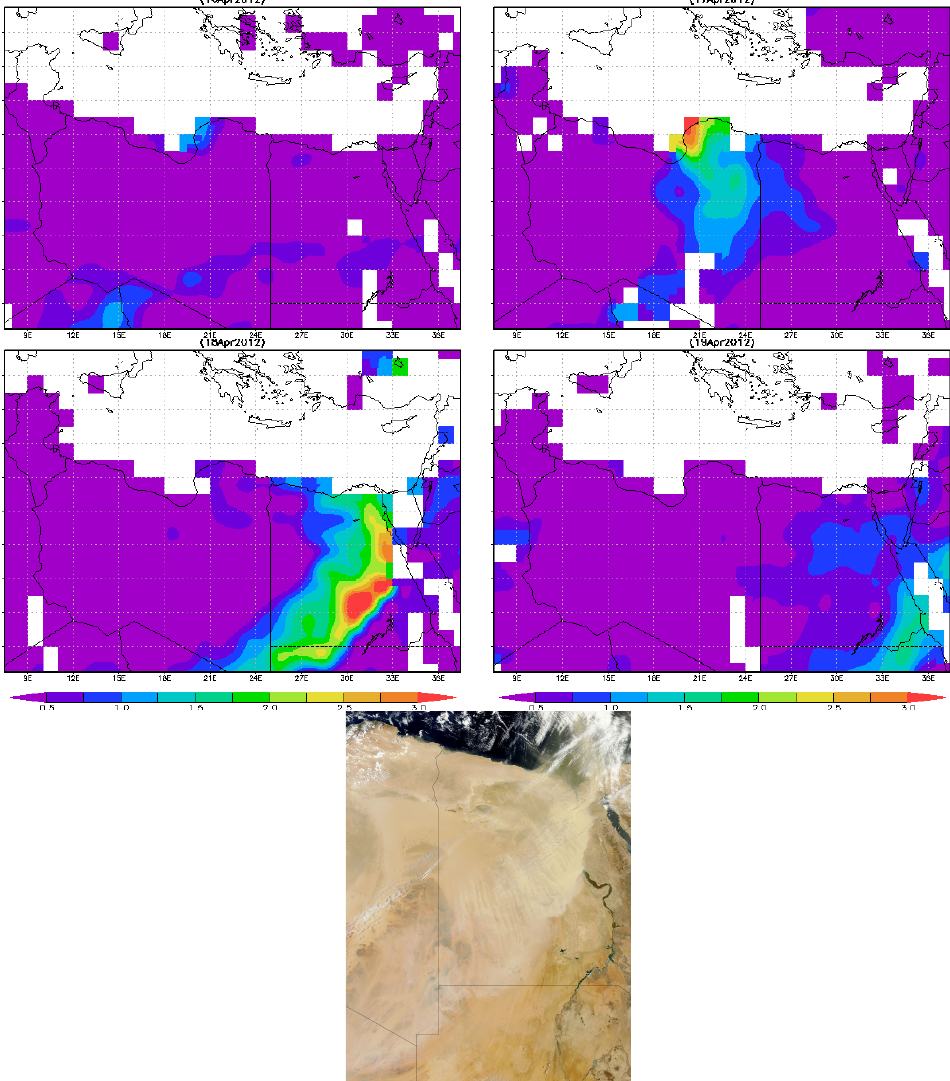
Figure 3. AOD at 550nm from MODIS on Aqua, Deep Blue algorithm, daily average for 16, 17, 18 and 19 April 2012. Below: visible image from MODIS/Terra acquired on 18 April 2012 at 09:00LT. Source: